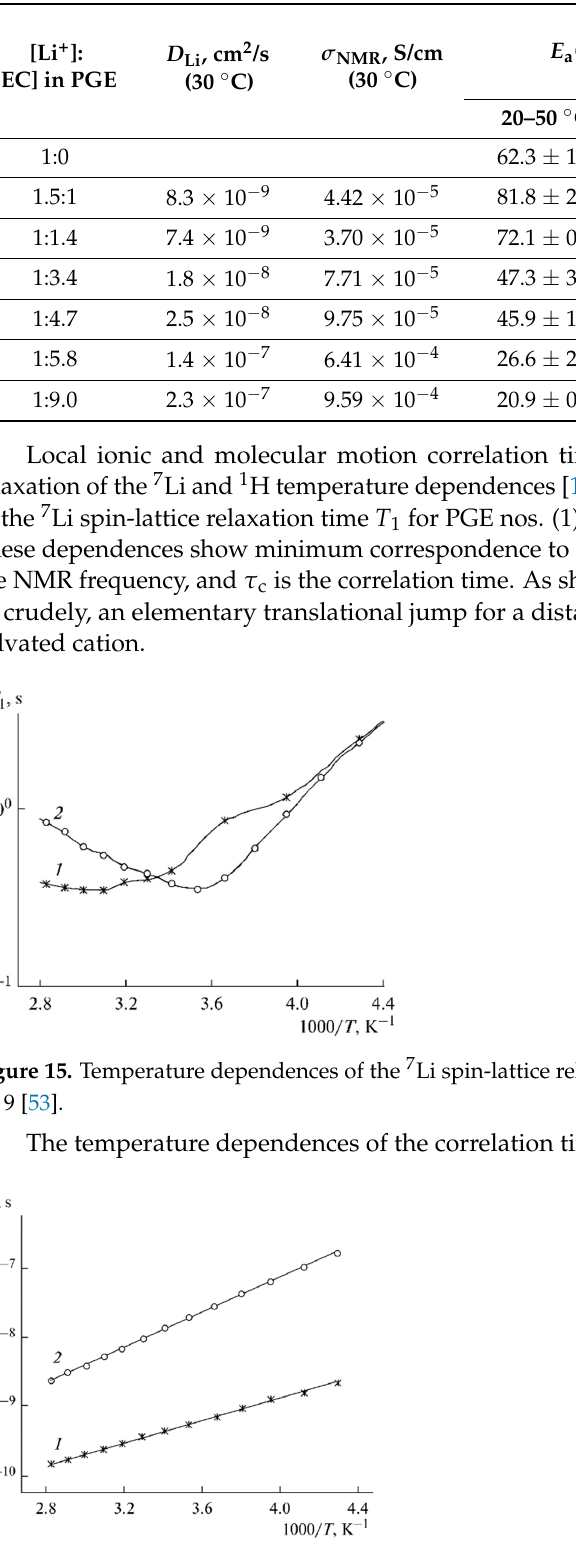
Table 5. Self-diffusion coefficients of lithium D Li , calculated conductivity σ NMR , activation energies of self-diffusion E a , and conduction E a ( σ sp ) at different ethylene carbonate concentrations [53].